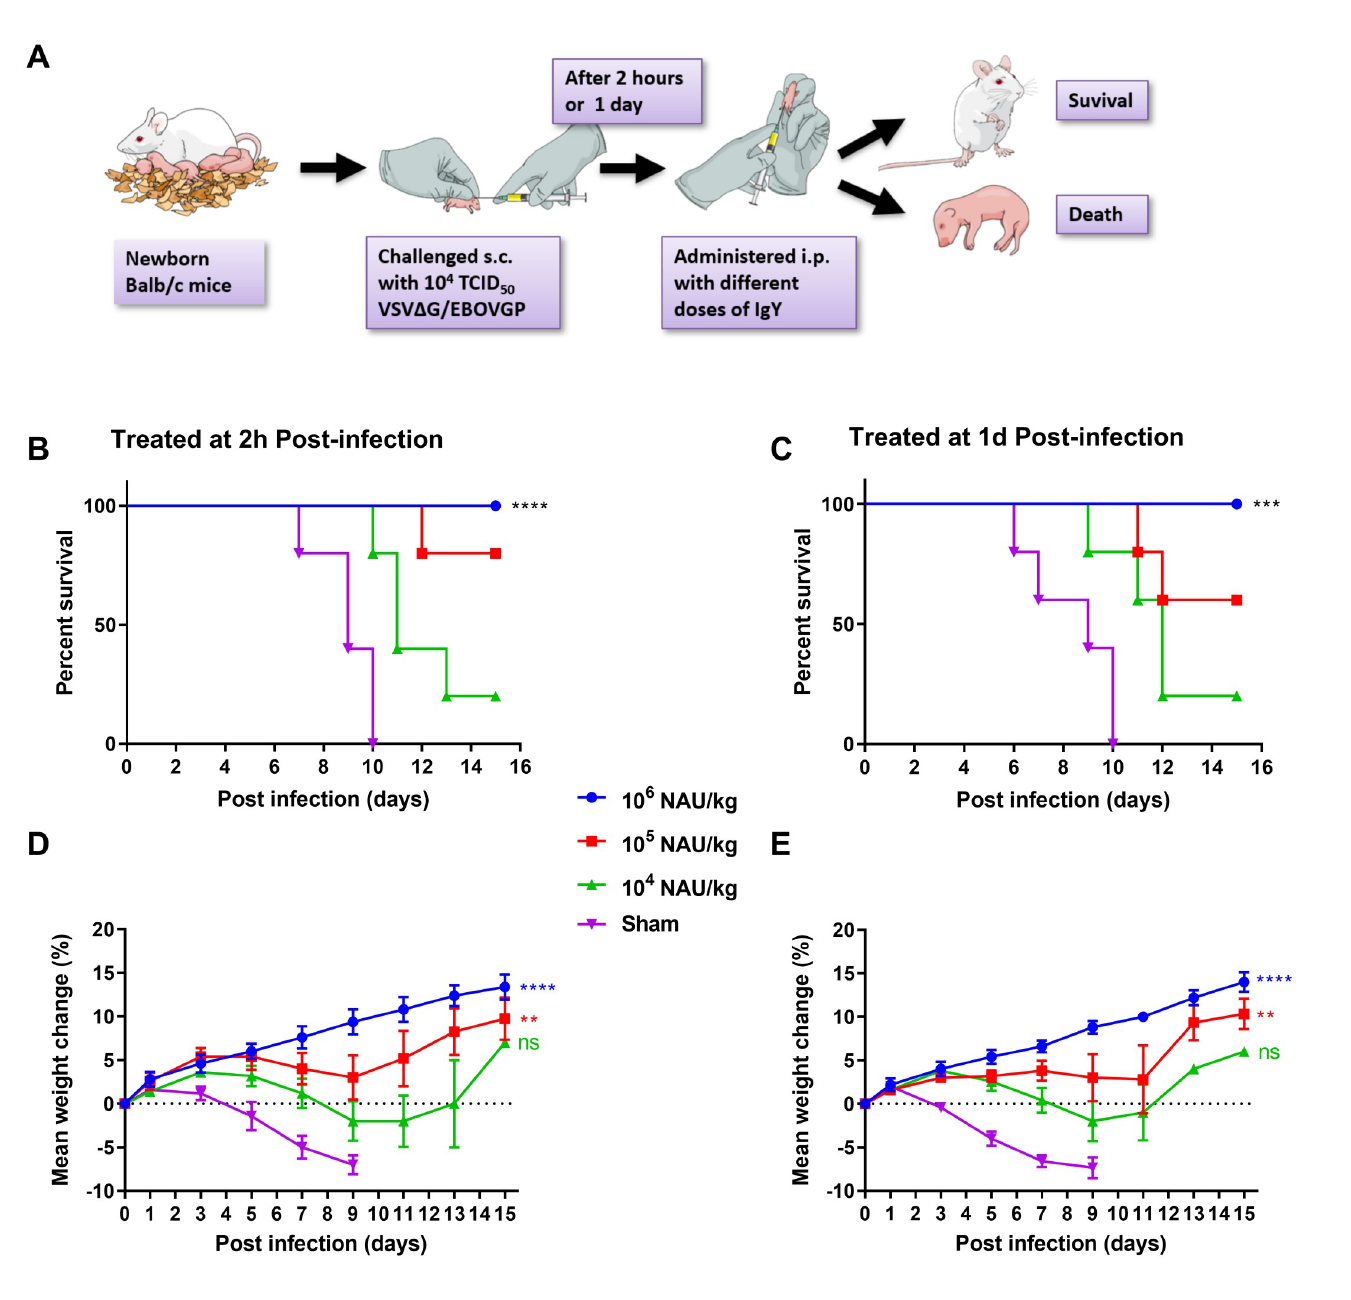
Fig 4. Passive protection of anti-EBOV IgY in newborn Balb/c mice pseudovirus challenge model. Experimental scheme (A). Eight groups of newborn Balb/c mice (3-day-old, n = 5 per group) were challenged s.c. with 10 4 TCID50 VSV Δ G/EBOVGP, after 2 h or 1 day, each mouse was given different doses of IgY or na ï ve IgY via i.p. route twice daily over 3 days. The survival rates (B, C) and body weight changes (D, E) were monitored and recorded daily. Survival data were analysed by two-sided log- rank test. Weight change was analysed by Tukey–Kramer multiple comparison test. Data are shown as means ± SEM. In all panels with P values: no significant difference (ns) P > 0.05; � P < 0.05; �� P < 0.01; ��� P < 0.001; ���� P <